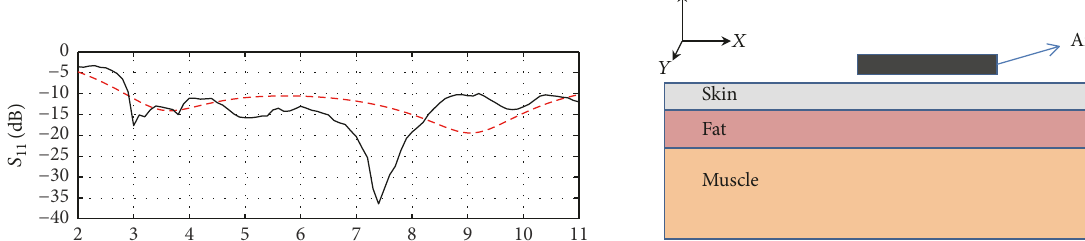
Figure 12: Dispersive phantom model with three